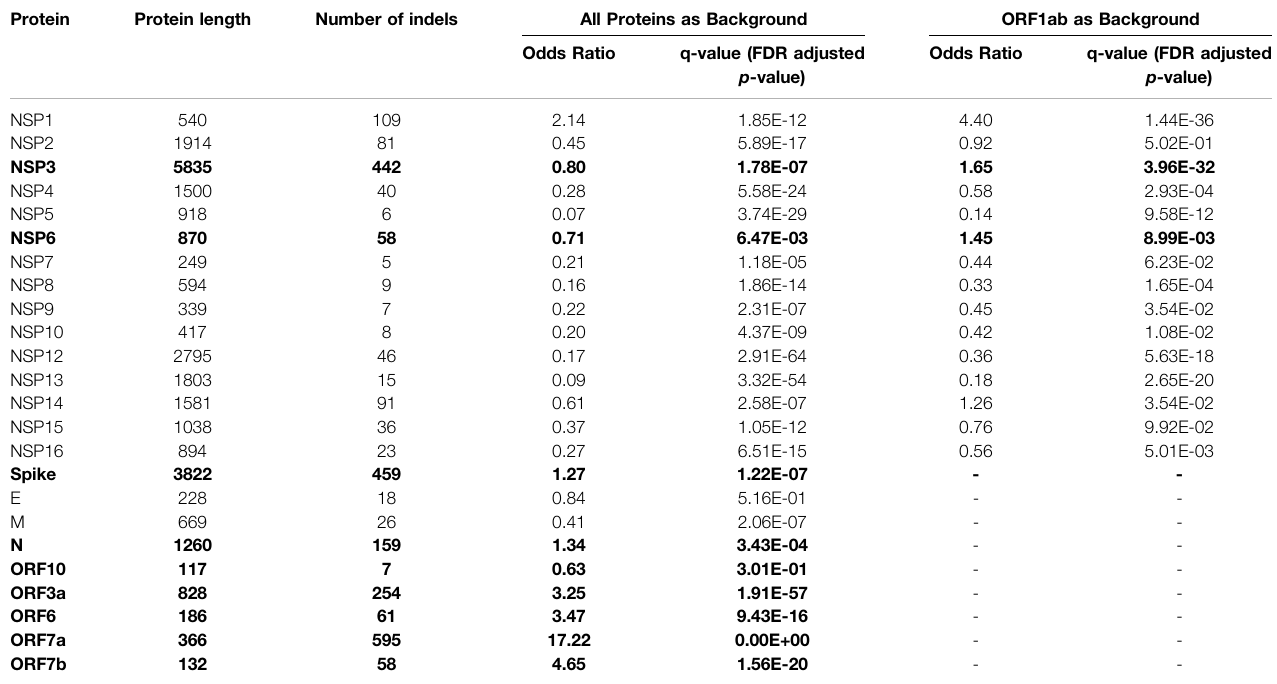
TABLE 1 | Comparison of frequencies of in-frame indels (indels) in SARS-CoV-2 proteins using the two-sided binomial test (only indels observed in at least two genomes were included to eliminate spurious mutations). Bold font indicates proteins with a signi fi cantly increased rate of indels (q-value < 0.01 and Odds ratio > 1). Protein Protein length Number of indels All Proteins as Background ORF1ab as Background Odds Ratio q-value (FDR adjusted Odds Ratio q-value (FDR adjusted p -value) p